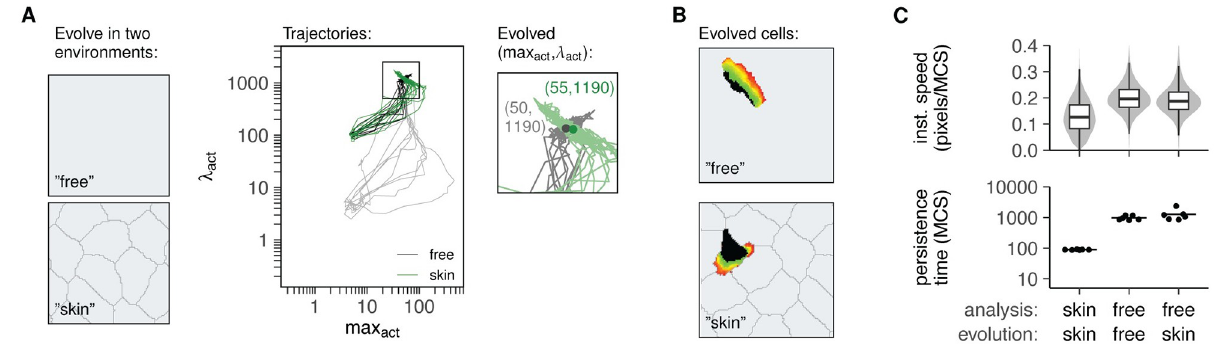
Fig 4. Act cells in different environments evolve similar parameters but different shapes and behaviour. A: Evolution trajectories of the (max act , λ act ) parameters compared between different runs of evolution in empty space (“free”, see also Fig 2) and evolution in a rigid simulated tissue (“skin”). Black lines represent the “free” cells evolved from the higher λ act = 100, while gray lines show the trajectories from Fig 2. Zoomed square shows where parameters converge in the two different environments after 50 generations, at similar (max act , λ act ) values. B: Cells evolved in different environments have similar parameters but different shapes and behaviours. See also S1 Movie. C: Speed and persistence of cells with parameters evolved in simulated skin (“skin-skin”), parameters evolved in an empty environment(“free-free”), or parameters evolved in simulated skin but analysed in an empty environment (“free-skin”). Speeds are represented as instantaneous speeds of each individual step in the simulation, and persistence times reflect 6 independent measurements at the same parameters (see Methods for